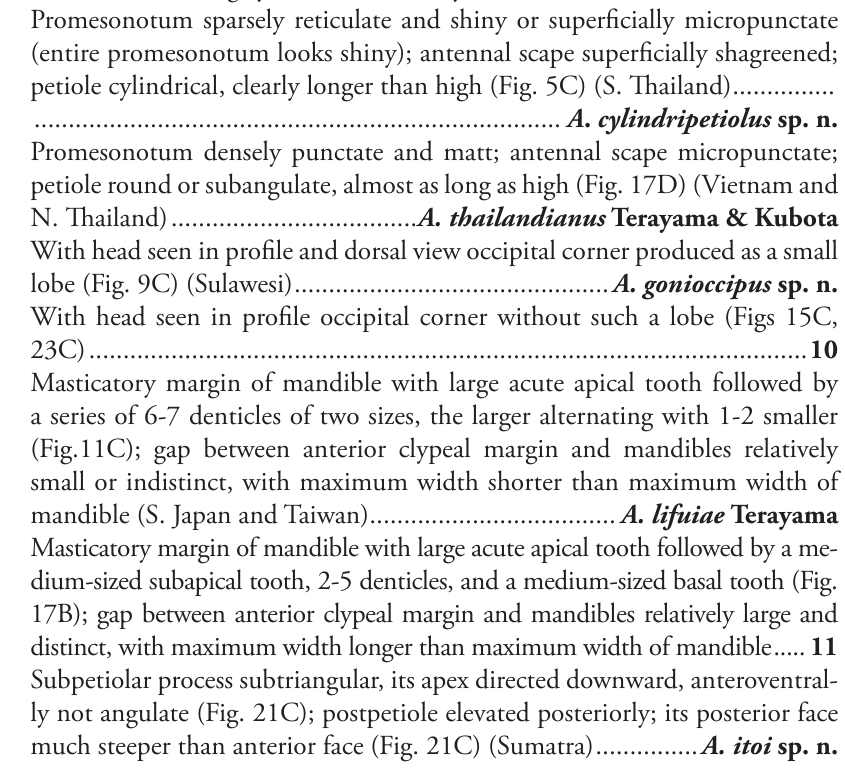
Distal 2/3 of basal margin of mandible straight, proximal 1/3 narrowed to- ward base of mandible; anterior clypeal margin straight; petiole clearly small- er than postpetiole (Fig. 14C) (Lombok) ................... A . minipetiolus sp. n. – Basal margin of mandible feebly concave; anterior clypeal margin concave; petiole larger than or as large as postpetiole (Figs 2C, 20C) ........................ 5 5 Promesonotum strongly convex and sloping gradually to metanotal groove; subpetiolar process with angulate posteroventral corner (Fig. 2C); antennal scape relatively long (SI 78-86) (Bali) ................................ A . baliensis sp. n. – Mesosoma almost flat dorsally or feebly convex; subpetiolar process lower, with its posteroventral corner rounded (Fig. 20C); antennal scape relatively short (SI 57-78) (Vietnam and Thailand) ................. A . wiwatwitayai sp. n. 6 Vertex with 2 long standing hairs mixed with a few short appressed hairs; promesonotum with few appressed hairs and a few decumbent hairs (Fig. 1C) (Sabah) ................................................................... A . appressipilosus sp. n. – Vertex and promesonotum with dense standing or decumbent hairs (Figs 10C, 13C, 15C, 16) ................................................................................... 7 7 Promesonotum entirely sculptured (punctate or reticulate) ......................... 8 – Promesonotum largely smooth and shiny .................................................... 9 8 Promesonotum sparsely reticulate and shiny or superficially micropunctate (entire promesonotum looks shiny); antennal scape superficially shagreened; petiole cylindrical, clearly longer than high (Fig. 5C) (S. Thailand) ............... ............................................................................. A . cylindripetiolus sp. n. – Promesonotum densely punctate and matt; antennal scape micropunctate; petiole round or subangulate, almost as long as high (Fig. 17D) (Vietnam and N. Thailand) .................................... A. thailandianus Terayama & Kubota 9 With head seen in profile and dorsal view occipital corner produced as a small lobe (Fig. 9C) (Sulawesi) .............................................. A. gonioccipus sp. n. – With head seen in profile occipital corner without such a lobe (Figs 15C, 23C) ......................................................................................................... 10 10 Masticatory margin of mandible with large acute apical tooth followed by a series of 6-7 denticles of two sizes, the larger alternating with 1-2 smaller (Fig.11C); gap between anterior clypeal margin and mandibles relatively small or indistinct, with maximum width shorter than maximum width of mandible (S. Japan and Taiwan) .................................... A. lifuiae Terayama – Masticatory margin of mandible with large acute apical tooth followed by a me- dium-sized subapical tooth, 2-5 denticles, and a medium-sized basal tooth (Fig. 17B); gap between anterior clypeal margin and mandibles relatively large and distinct, with maximum width longer than maximum width of mandible ..... 11 11 Subpetiolar process subtriangular, its apex directed downward, anteroventral- ly not angulate (Fig. 21C); postpetiole elevated posteriorly; its posterior face much steeper than anterior face (Fig. 21C) (Sumatra) ............... A. itoi sp.